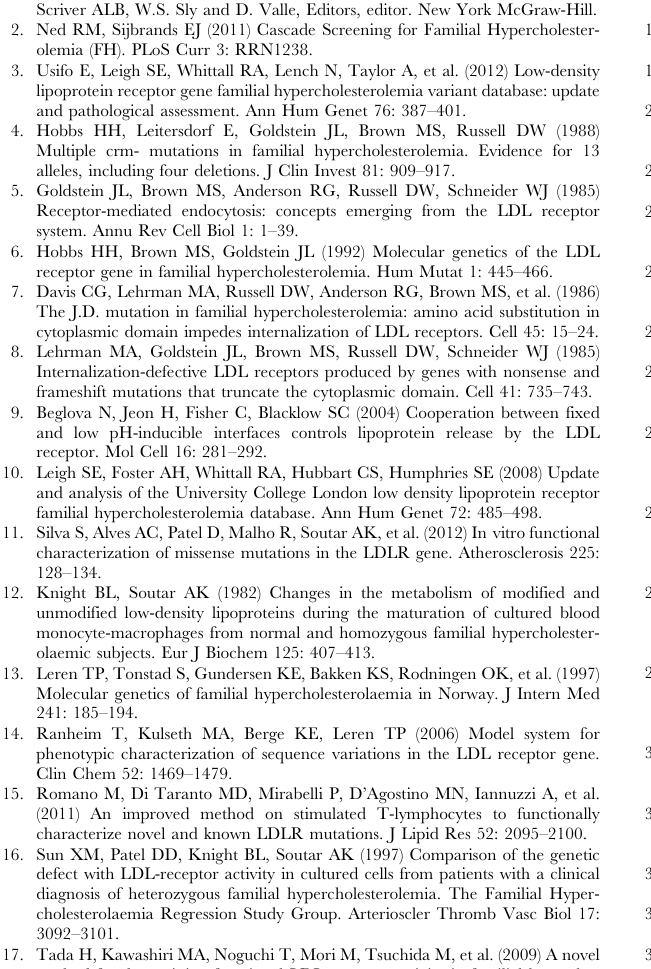
better turn to form the barrel. Two consecutive prolines could Figure S5 Structure of the interface of b -propeller in green and EGF-C in blue (A). Pro685 establishes hydrophobic contacts with b -propeller. Ser685, due to its polarity could disturb this contact (B). This figure was prepared with PyMOL (DeLano scientifics) (PDB:1N7D) (PDB:3S06).